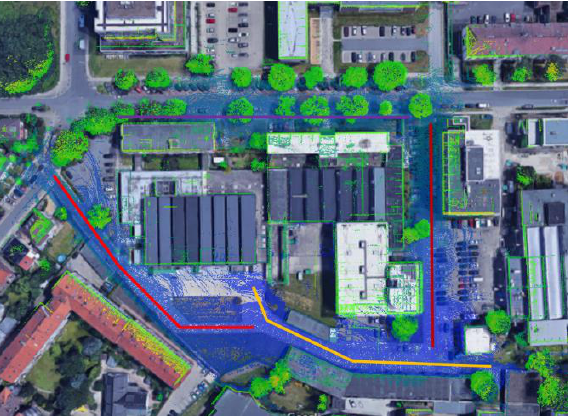
Figure 12: Merged maps of Figure 11 overlaid with satellite imagery. Trajectories of agents are drawn in color. Trajectory for map (a) is shown in light red, trajectory for map (b) is shown in yellow, trajectory for map (c) is shown in dark red and trajectory for map (d) is shown in purple.